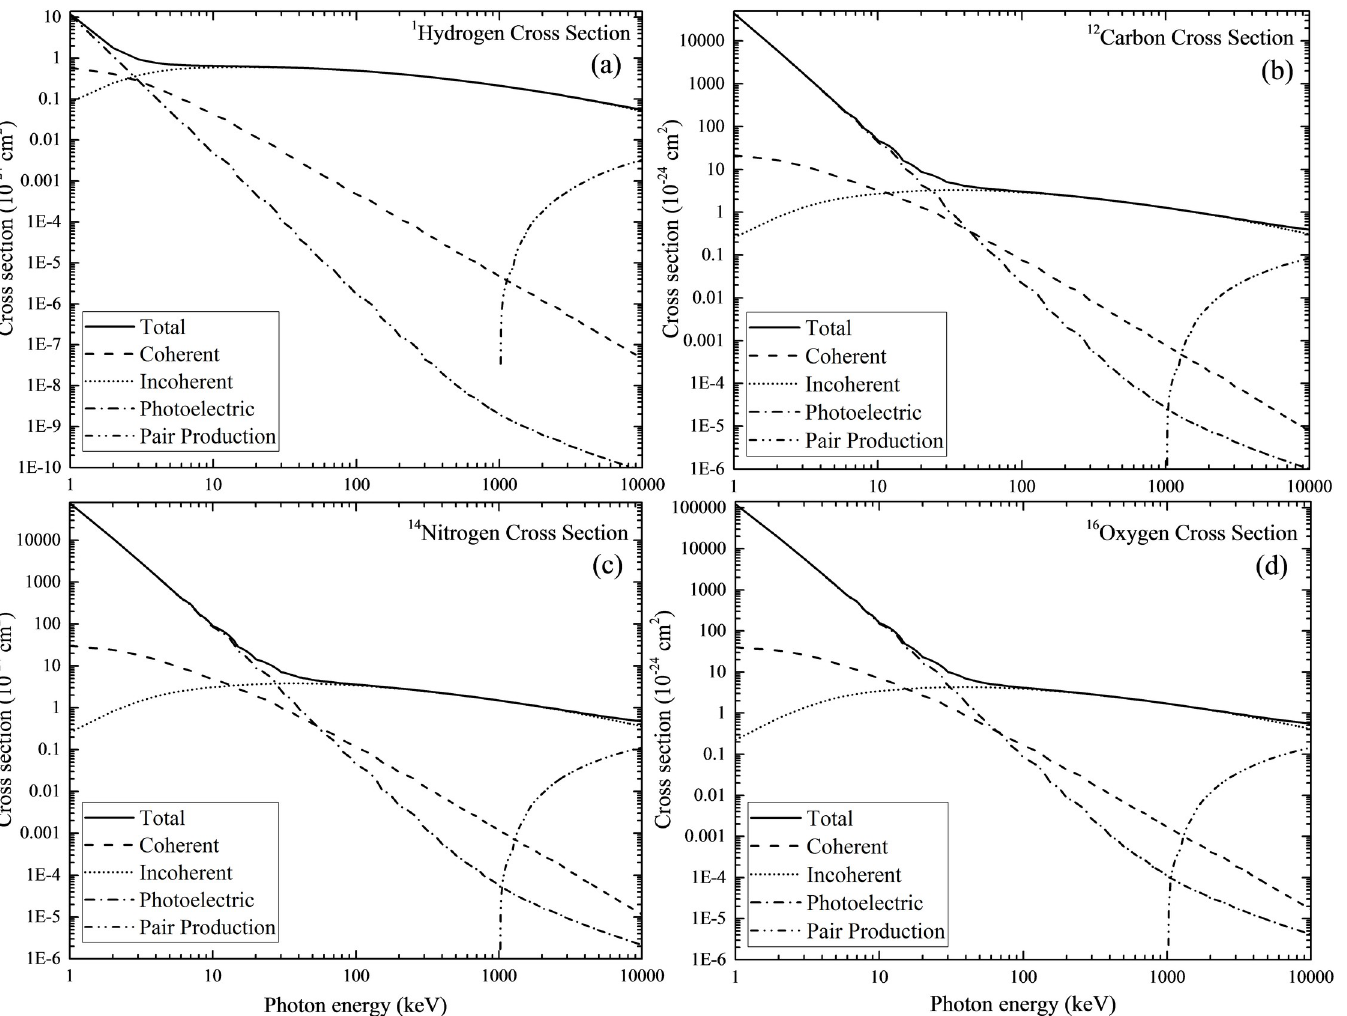
Fig 1. Interaction cross-section data for 1 H, 12 C, 14 N and 16 O that are the major nuclei in a modeled human cell or organ. The four different interactions shown in the figure include coherent, incoherent, photoelectric effect and pair production. These were obtained from the National Institute of Standards and Technology